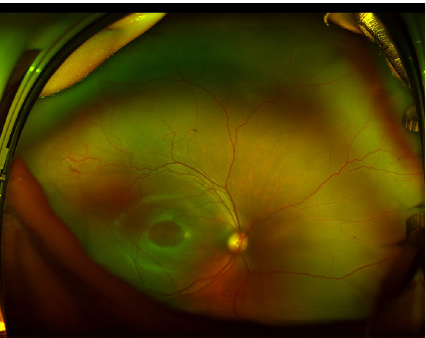
Figure 2. Ultra-wide-field pseudocolour image of a male patient (case #4) weighing 1460 g at birth (32 weeks of gestational age at birth and 39 weeks of corrected gestational age at the first examination) who was diagnosed with zone II/stage 1 ROP. The image shows angiogenesis towards the temporal mid-peripheral retina. Regardless of the lack of visualization of the far periphery, details of the posterior pole’s development and maturation, such as complete vascularization of the temporal arcades and foveal depression, can be observed.